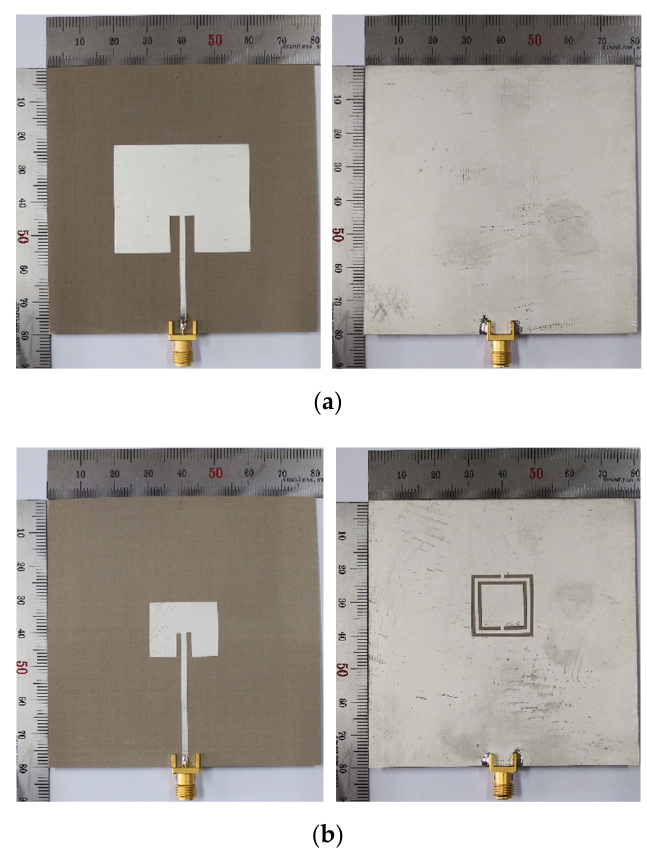
Figure 10. Photographs of the fabricated MPSAs: ( a ) the conventional MPSA; and ( b ) the proposed scaled DR-CSRR-RA DGS-loaded MPSA. Sensors 2020 , 20 , x FOR PEER REVIEW